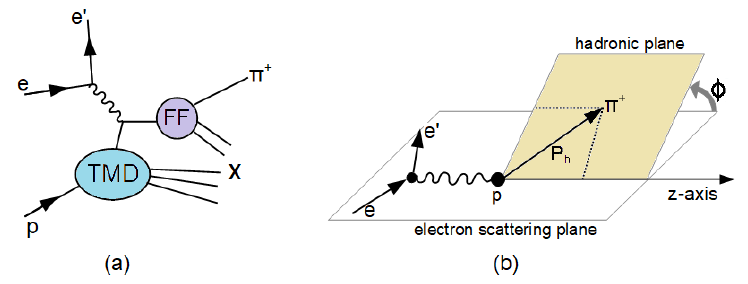
Figure 1: (a) Schematic diagram of the single pion semi-inclusive deep inelastic scat- tering process with the involved parton distributions and fragmentation